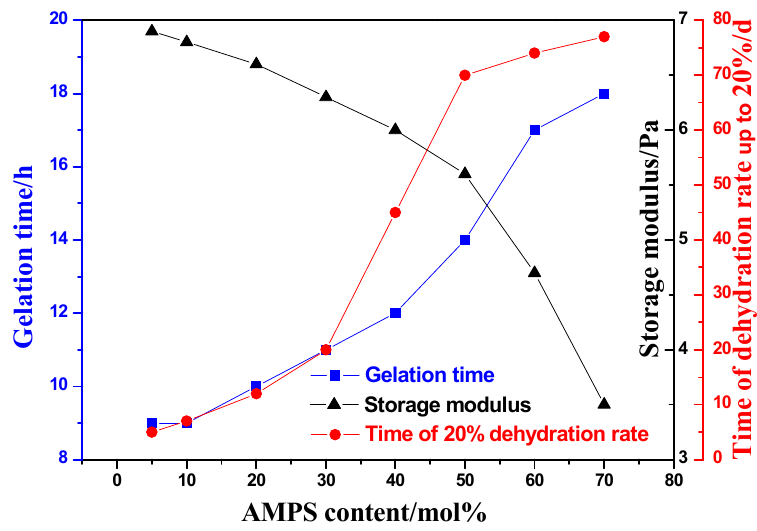
Figure 2. Effects of AMPS content on properties of gels.